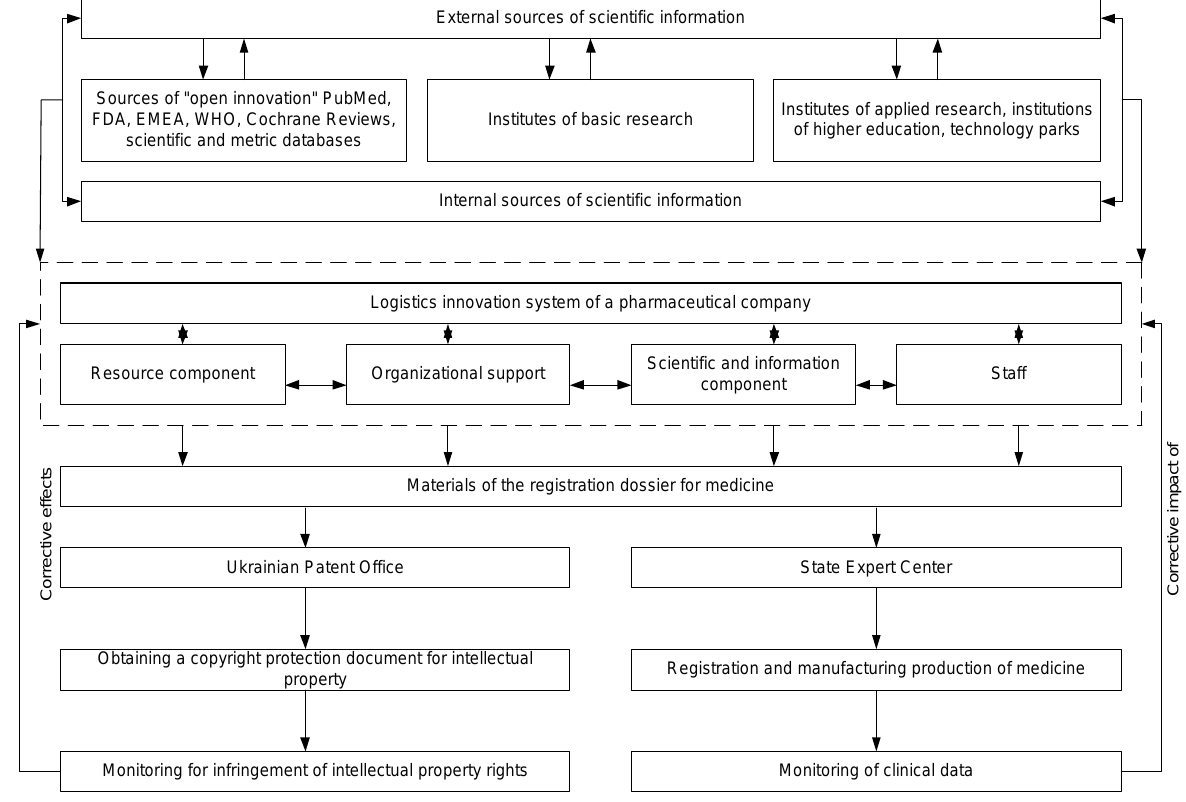
Fig. 2 Pharmaceutical company as a converter of information and innovation